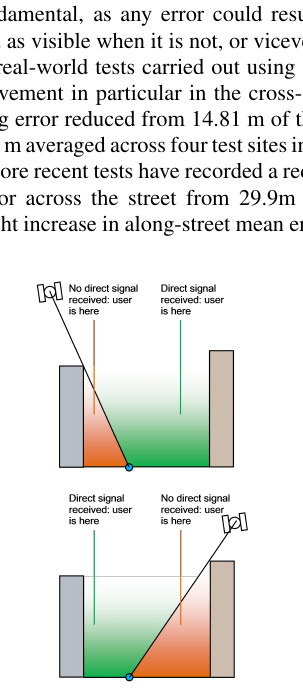
Figure 2: Principles of Shadow Matching (Groves et al.,